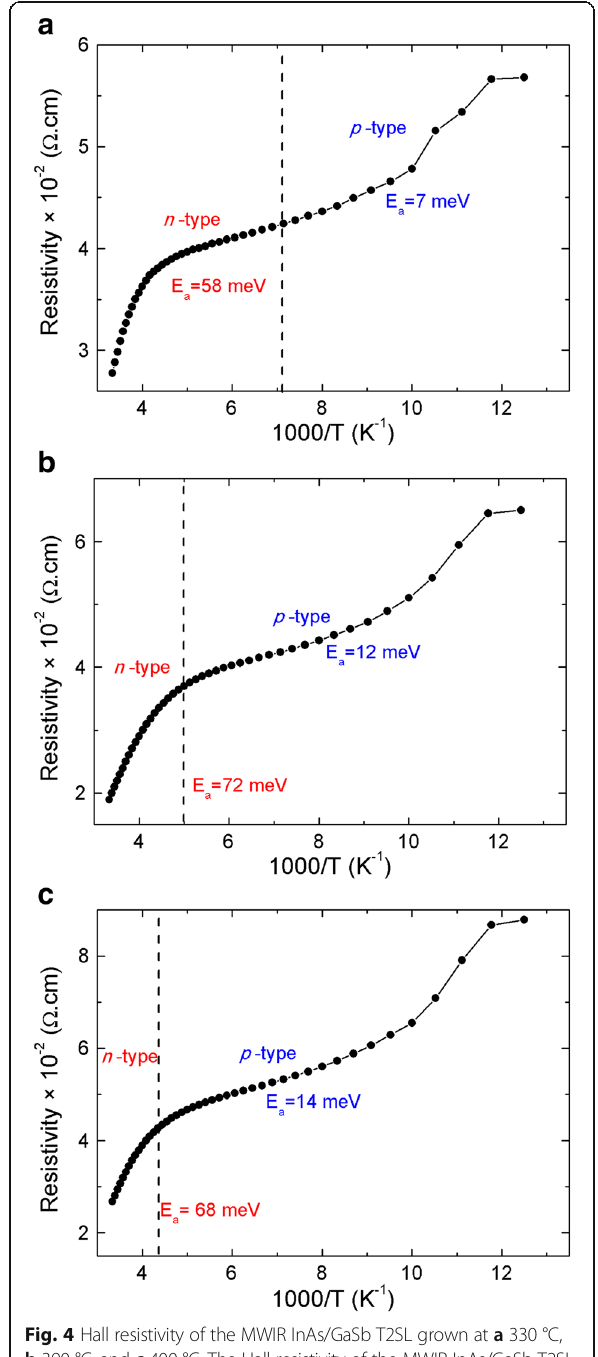
Fig. 4 Hall resistivity of the MWIR InAs/GaSb T2SL grown at a 330 °C, b 390 °C, and c 400 °C. The Hall resistivity of the MWIR InAs/GaSb T2SL deposited at different growth temperatures, a 330 °C, b 390 °C, and c 400 °C. For each graph, there are two well-defined slopes. From the Arrhenius law, two thermal energies can be extracted, which confirms the existence of two impurity levels. One represents the n -type carriers, and the second one corresponds to the p -type carriers. The deep impurity level associated to the n -type carriers is the result of the band lineup between InAs and InAs/GaSb